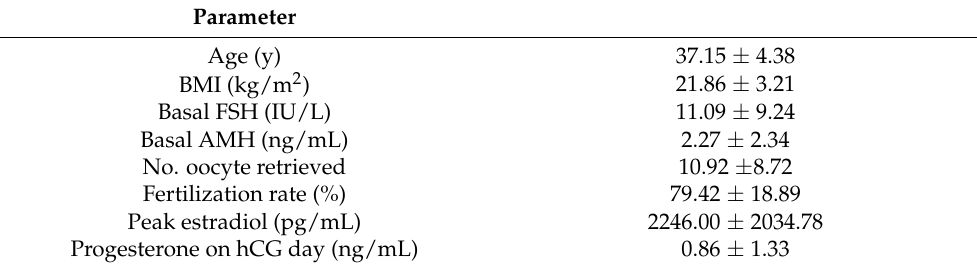
Table 2. Basic characteristics of patients for the ovarian stimulation of IVF